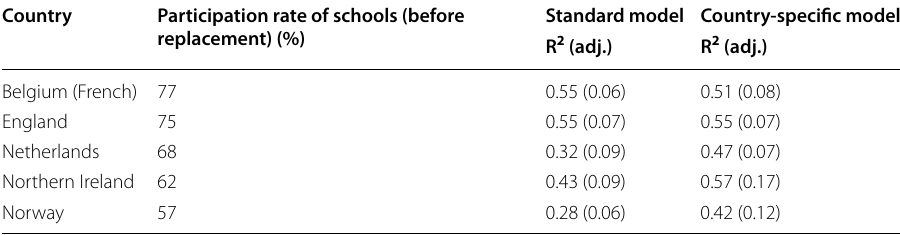
Standard errors appear in parenthesis